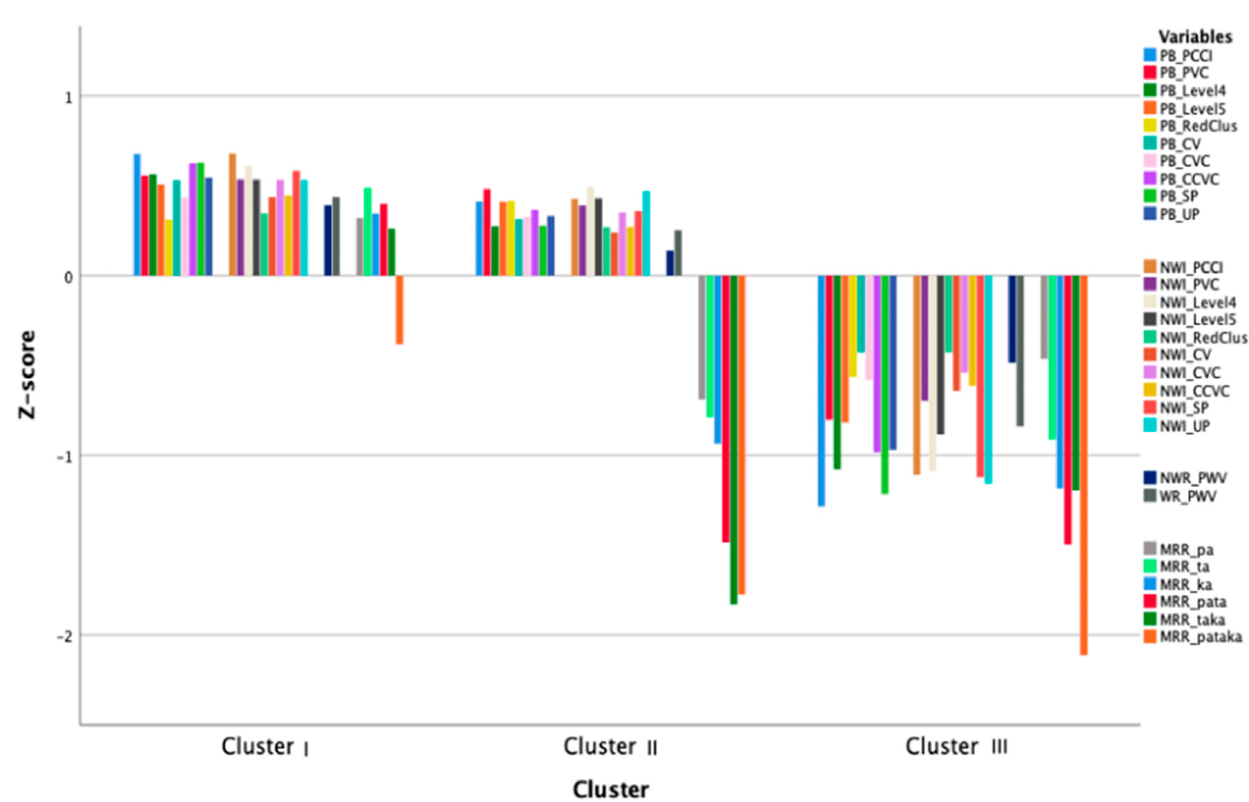
Figure 2. Overview of the distribution of the parameters across the clusters in